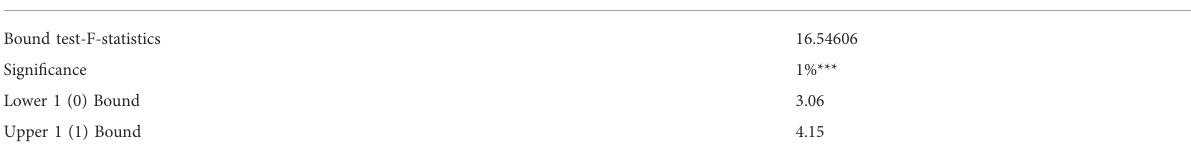
TABLE 6 Results of ARDL bounding test approach.